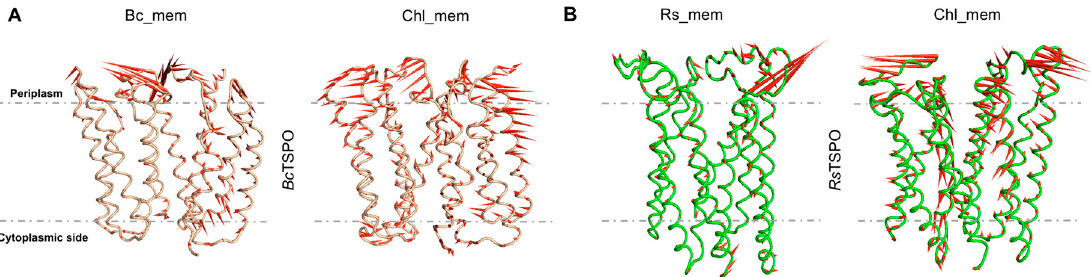
Figure 9. Porcupine plots depicting prominent motions averaged across the first normal mode for: ( A ) Bc TSPO in Bc_mem and chl_mem and ( B ) Rs TSPO in Rs_mem and chl_mem, respectively. A dotted line marks the approximate location of the membrane. Longer spines indicate the region with higher fluctuations for the first normal mode. These correspond to the periplasm loops. The analysis was performed on the equilibrated part of the trajectory, namely the last 1.3 μ s.